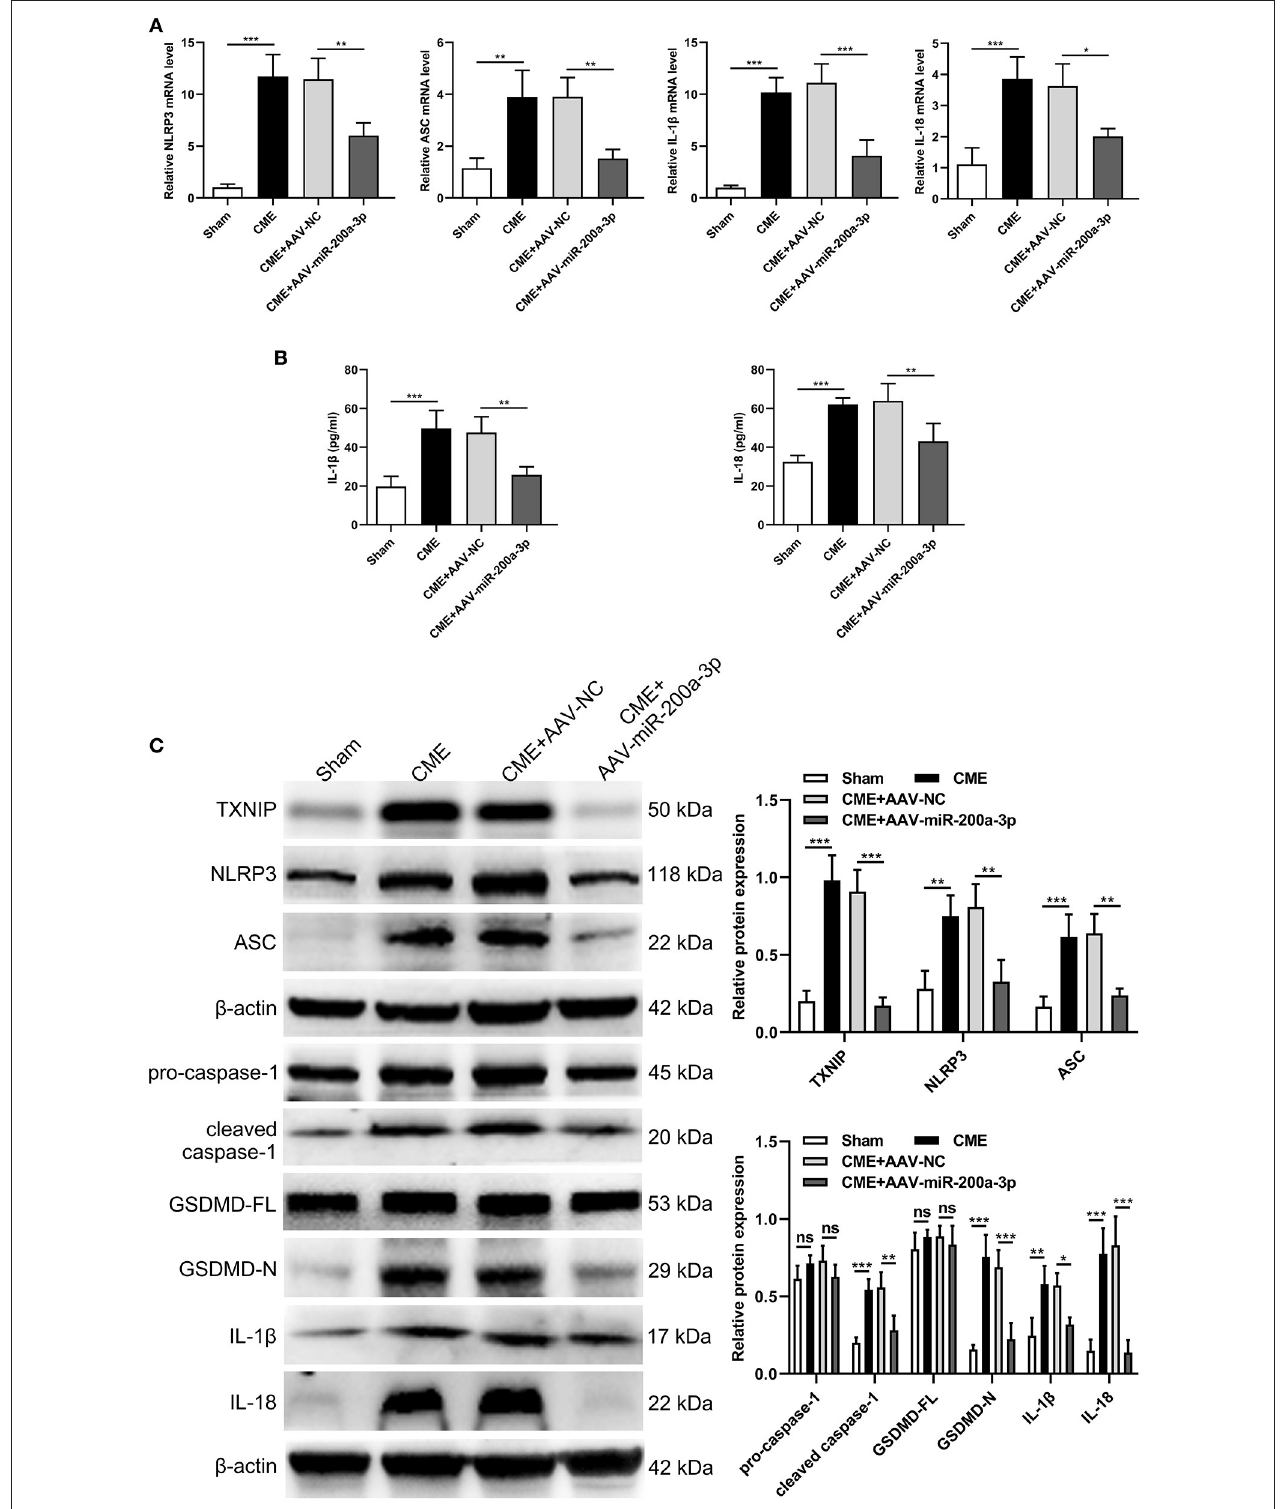
FIGURE 7 | miR-200a-3p overexpression decreases CME-induced cardiomyocyte pyroptosis via the inhibition of the TXNIP/NLRP3 pathway. (A) Myocardial NLRP3, ASC, IL-1 β , and IL-18 mRNA expression levels were assessed via qRT-PCR ( n = 4 per group). (B) Serum IL-1 β and IL-18 expression levels were assessed via ELISA ( n = 4 per group). (C) Myocardial TXNIP, NLRP3, ASC, pro-caspase-1, cleaved caspase-1, GSDMD-FL, GSDMD-N, IL-1 β , and IL-18 protein levels were assessed via